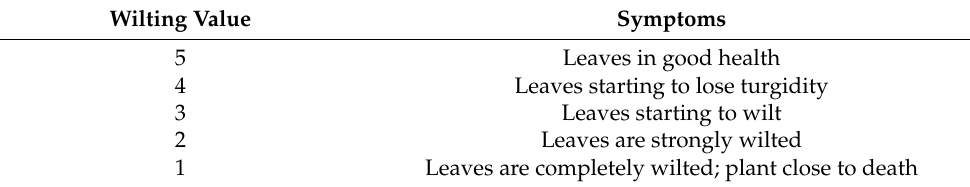
Table 1. Visual assessment scale. Wilting Value